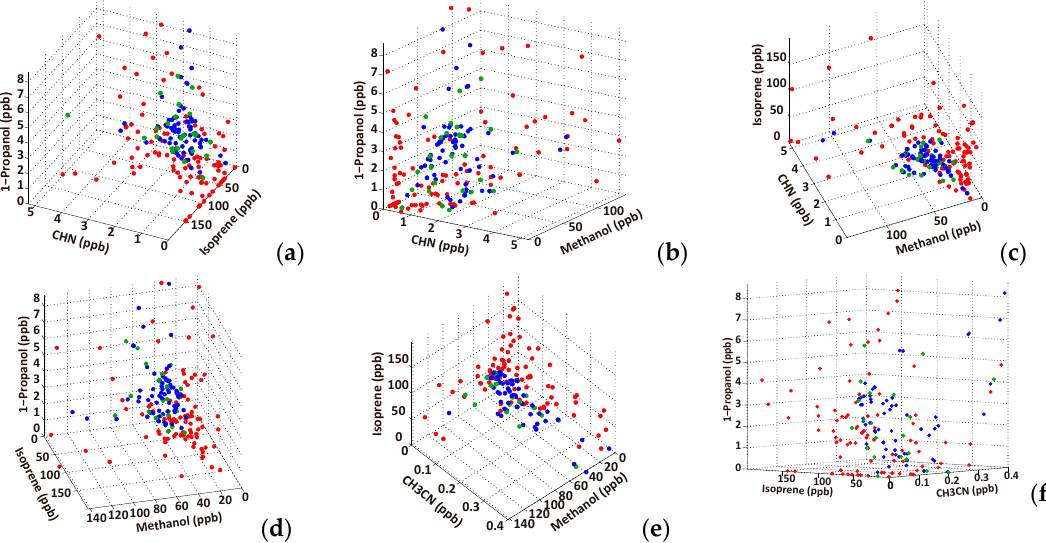
Figure 7. VOC distributions on a 3D representation for the list of top accuracy combinations in Table 5. CHN, isoprene, 1-propanol ( a ); CHN, methanol, 1-propanol ( b ); CHN, methanol, isoprene ( c ); isoprene, methanol, 1-propanol ( d ); CH 3 CN, methanol, isoprene ( e ); and isoprene, CH 3 CN, 1-propanol ( f ). The red and green circles represent lung cancer patients and healthy controls, respectively, and the blue circles indicate the oversampling data. The oversampling data are more widely spread than the original healthy samples in this range because some of the healthy samples exist outside of the axis range.